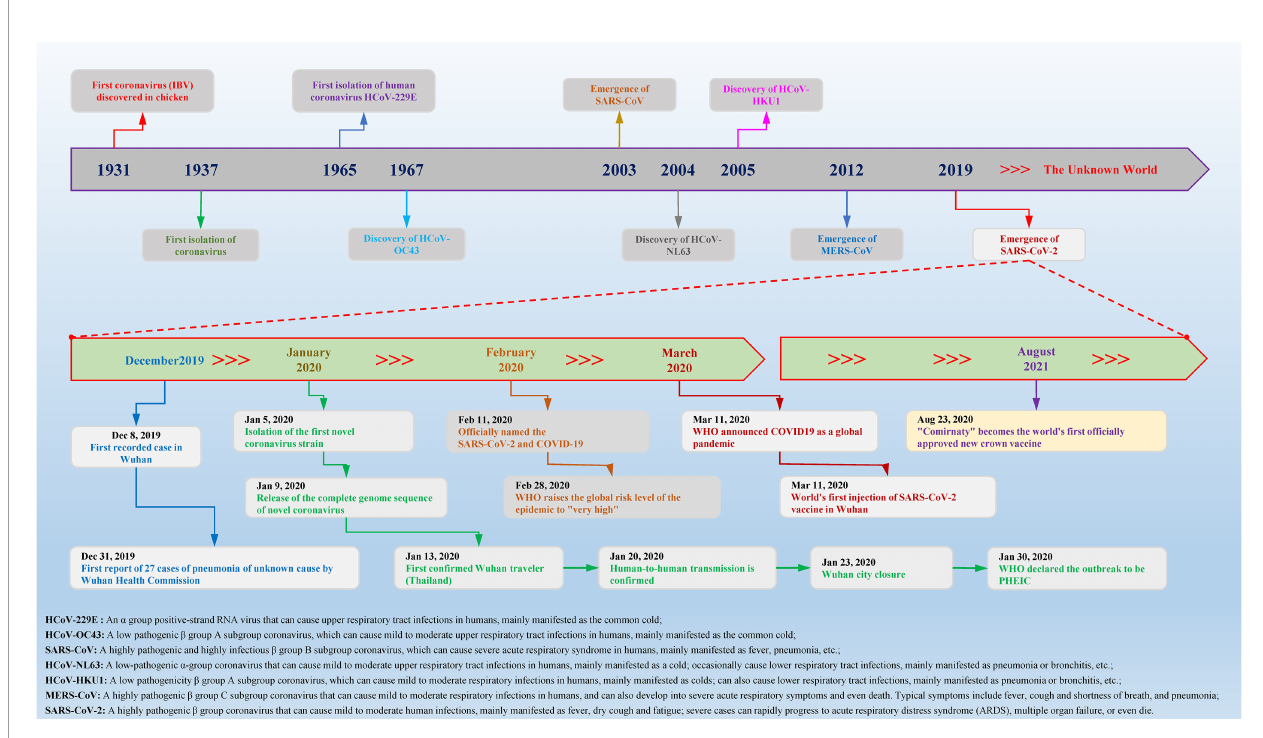
FIGURE 1 | Timeline of key events for coronavirus discovery and research. Coronavirus was fi rst isolated from chickens in 1937. With the passage of time and changes in the environment, in the past 84 years, a variety of different species and subgroups of coronaviruses have been discovered, identi fi ed, named, and researched. In December 2019, Wuhan, China, reported a novel coronavirus case for the fi rst time. In a short period of time, the COVID-19 epidemic caused by SARS-CoV-2 spread to the world and caused major disasters and epidemics. In the past two years, there have been more than 440 million con fi rmed cases worldwide, causing approximately 5.97 million deaths, which has caused great social upheavals and